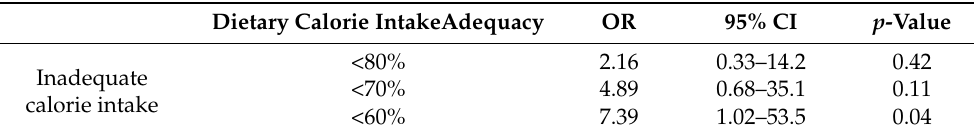
Table 3. Multivariate analysis of predictors of adverse clinical events including all-cause death and HF-related hospitalization in patients with chronic HF.